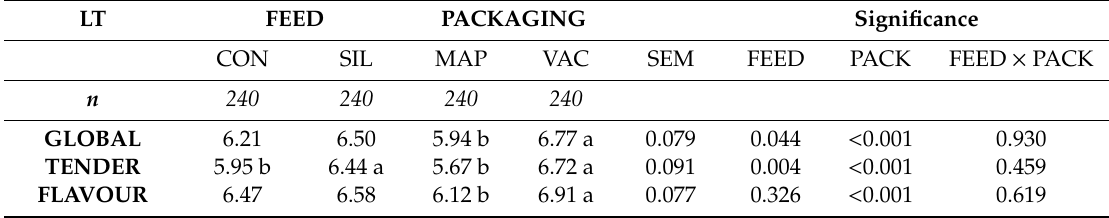
Table 7. E ff ect of feeding (concentrate (CON) vs. 70% maize silage + 30% concentrate (SIL)) and packaging (vacuum (VAC) and modified atmosphere (MAP)) on global, tenderness and flavour